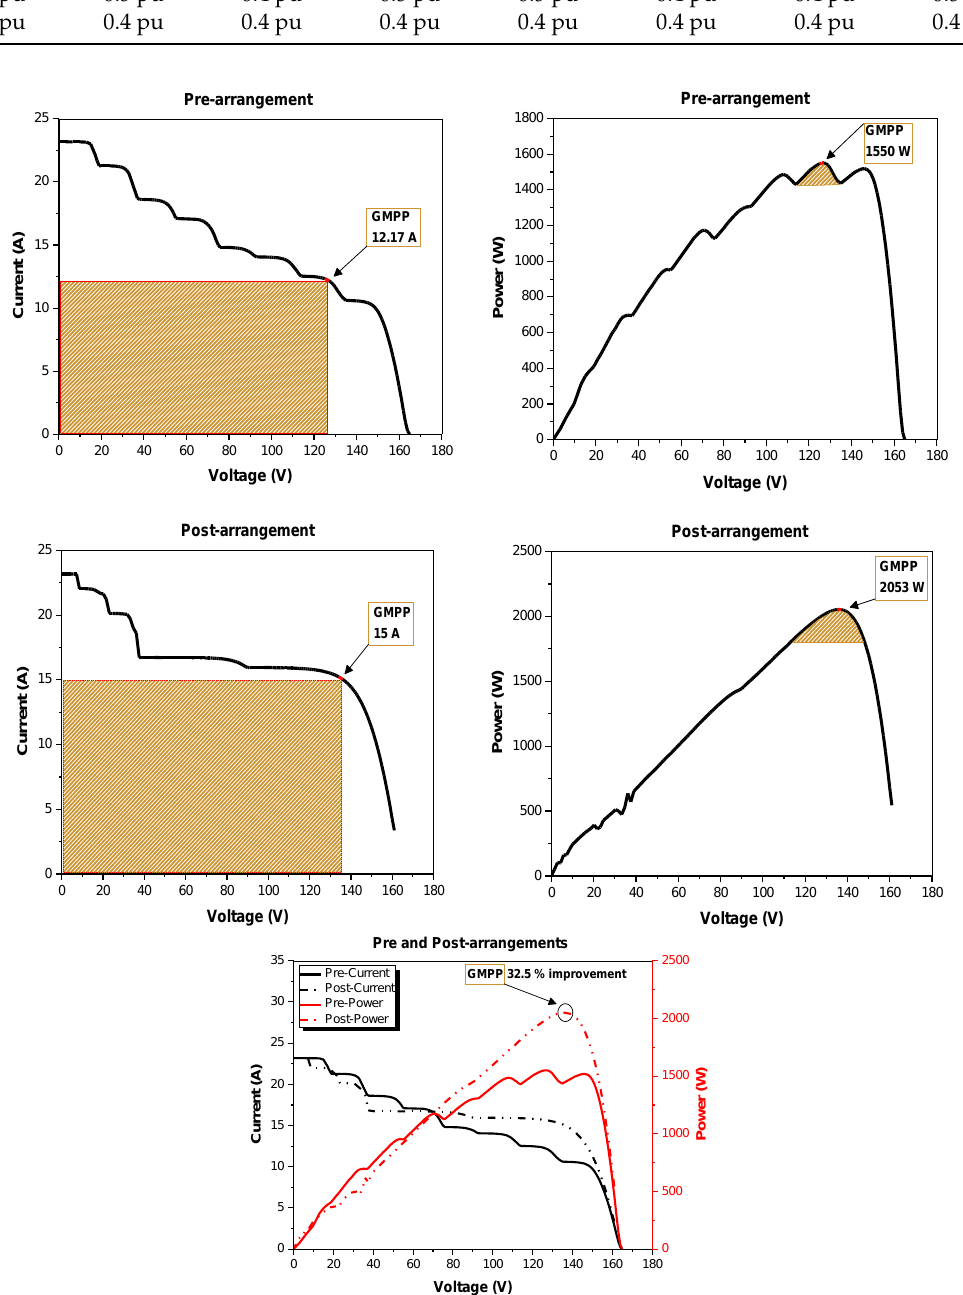
Figure 13. The output of a PV array (pre-post rearrangements) for case3.